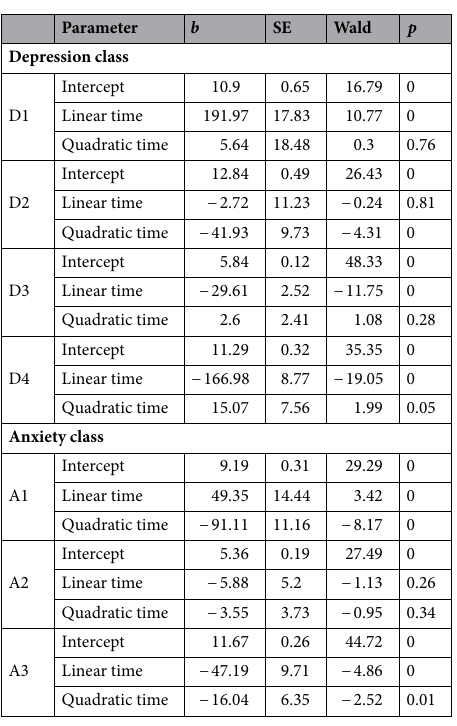
Table 4. Intercepts, linear and quadratic time parameters for each class of the selected growth mixture models. Time is coded in weeks.